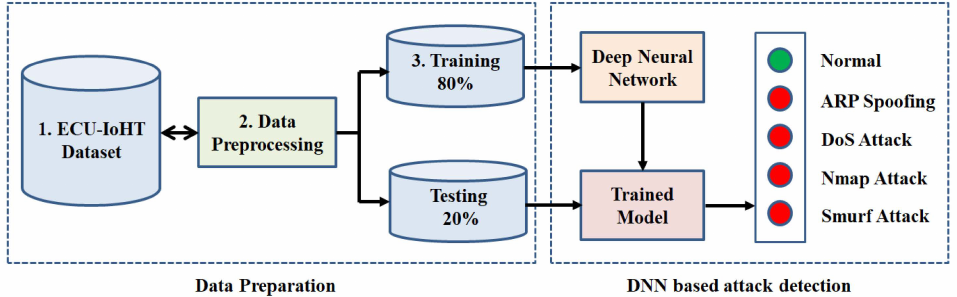
Figure 2. Proposed System .